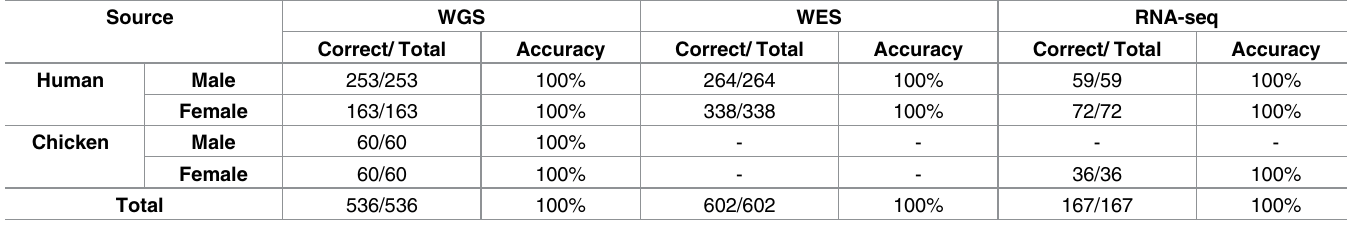
Table 4. Accuracyof sex identification by